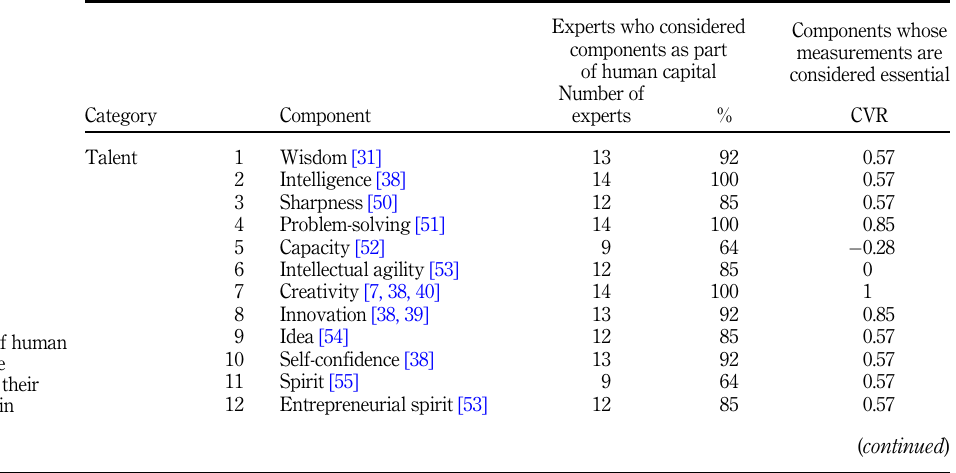
Table II. Definitions of IC domains